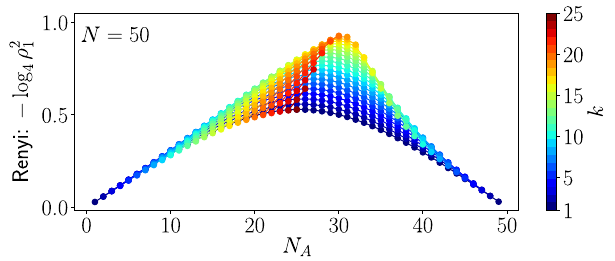
FIG. 4. Dark-state entanglement. Second Renyi entropy R 1 ≡ − log 4 ρ 2 1 , where ρ 1 denotes the single-particle reduced density matrix computed for dark states of a six-level system with 1 = 2 and F 3 = 2 . We show all the dark states for N ¼ 50 F g ¼ e ¼ with excitation number k ∈ ½ 1 ; N= 2 (cid:4) and number parameter N A which have no occupation in the j e − 3 and j e − 1 states as = 2 i k = 2 i k defined in Eq. (21). All dark states shown fulfill R 1 > 0 and are, therefore, entangled.